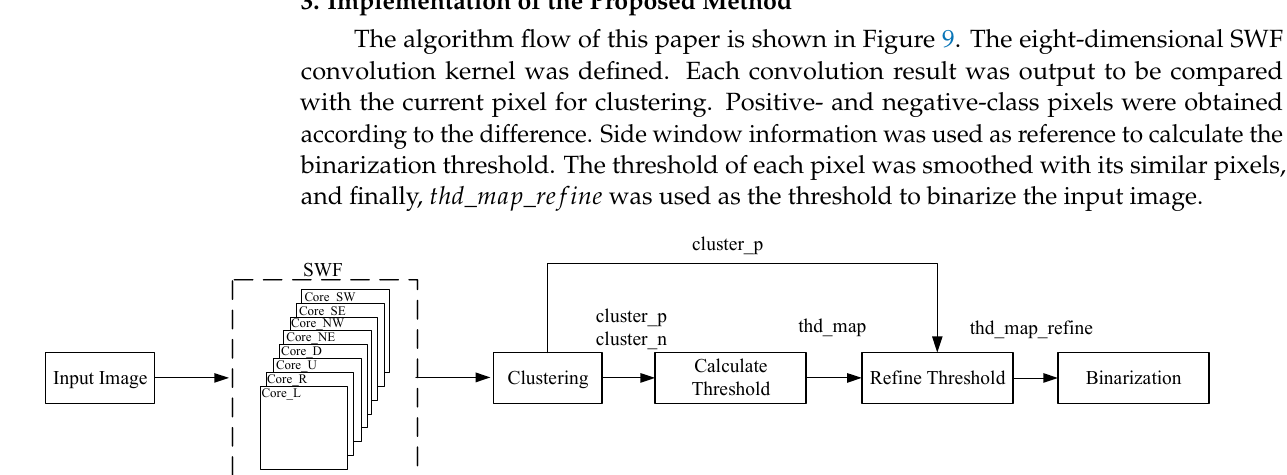
Figure 8. Within-class variance of test images binarized by SW and Box.